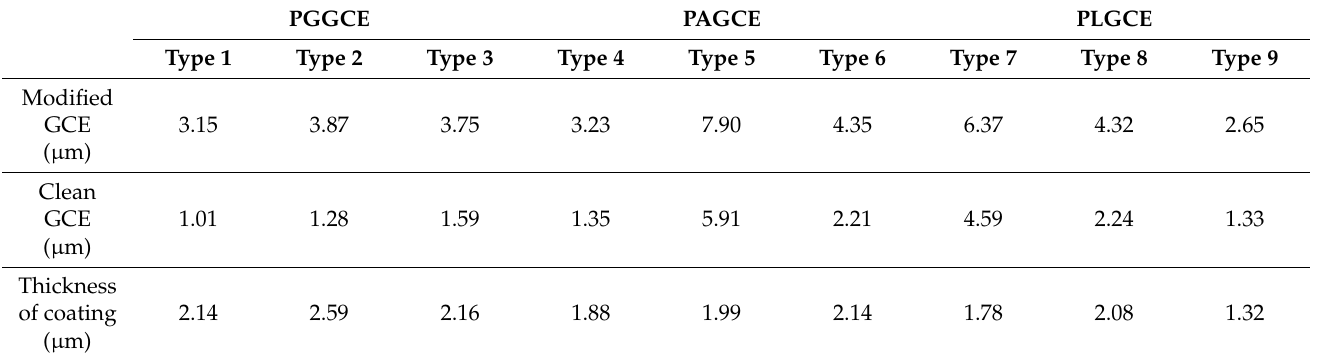
Table 2. The thickness of poly-amino acid coatings on the GCE surface calculated based on micro- scopic measurements of pure GCE and modified electrodes profiles. The calculation was made by the complete stoichiometric analyses of pyrazine-based drugs.